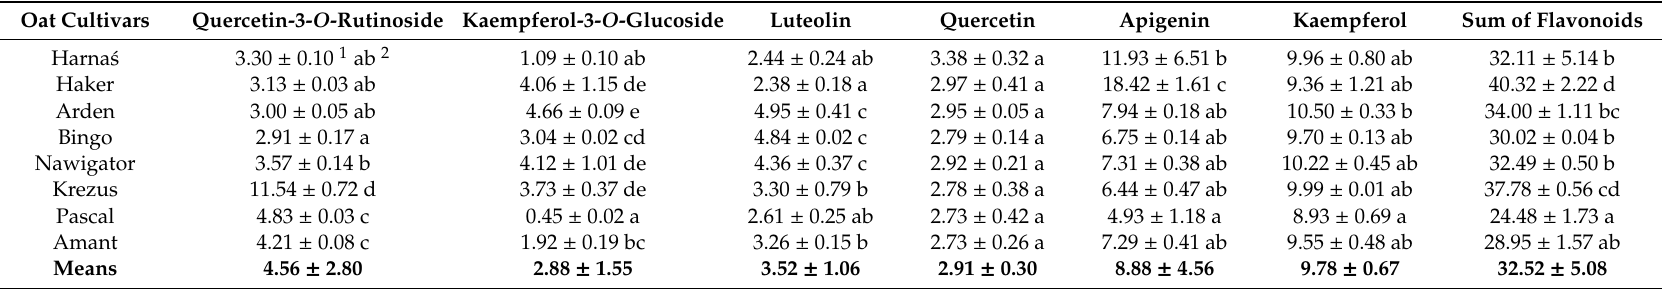
Table 5. Flavonoids concentrations (mg 100 g − 1 ) in the grain of eight oat cultivars grown organically in the controlled field trial in Poland. Oat